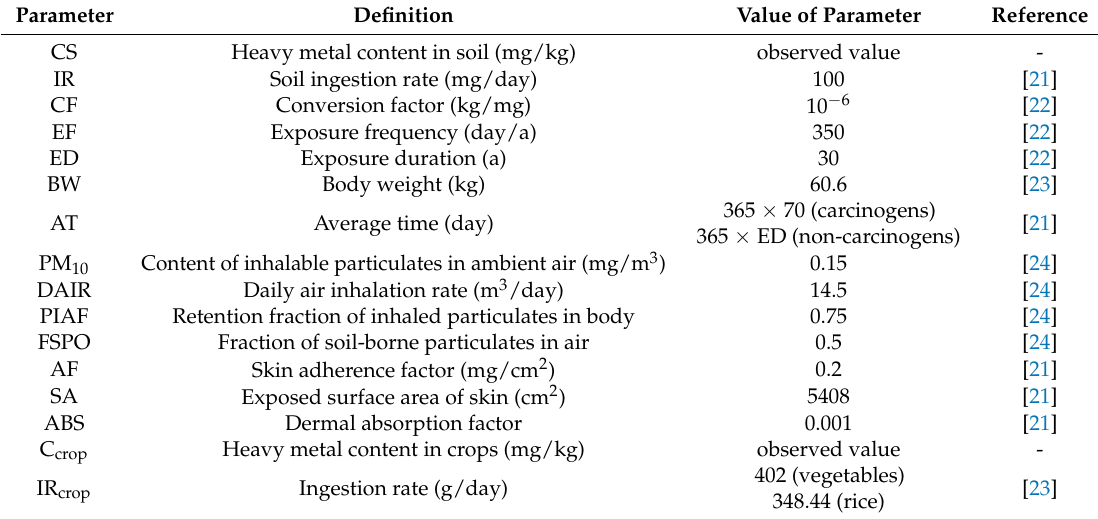
Table 2. The definition and value of exposure